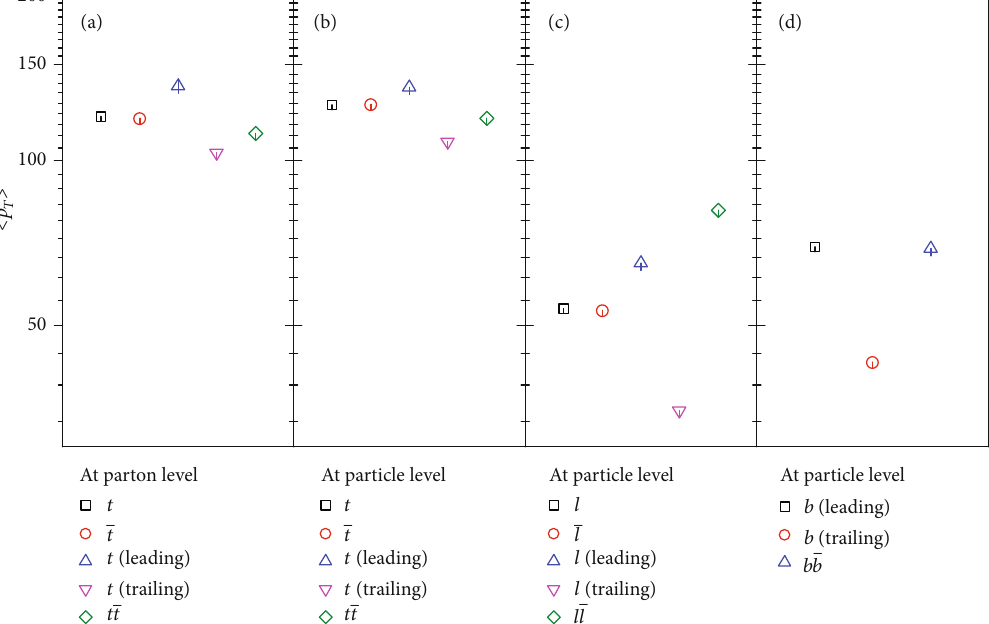
Figure 9: The values of h p